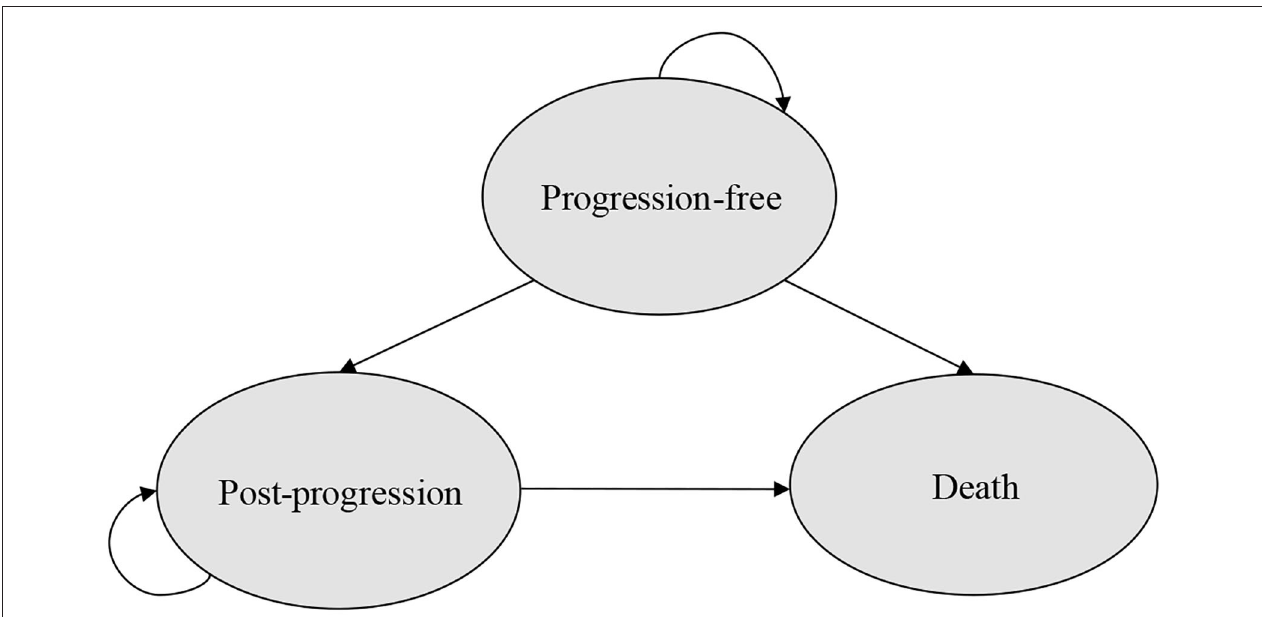
FIGURE 1 | Structure of the PS model.